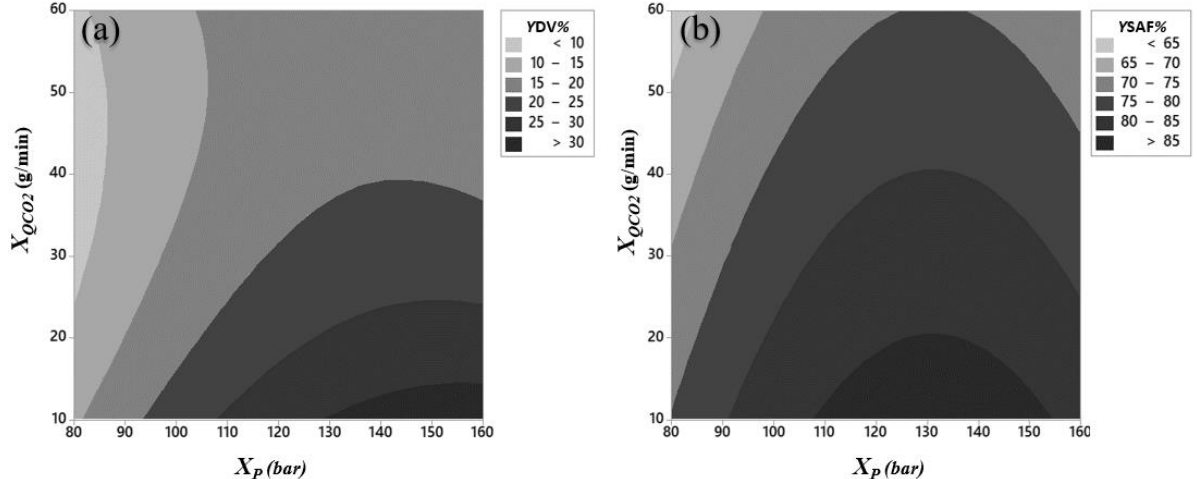
Figure 1. Contour plots of the yields: ( a ) at DV, Y DV % and ( b ) overall yield, Y SAF % as function of pressure, X P (bar) and CO 2 flow rate, XQ (g/min).